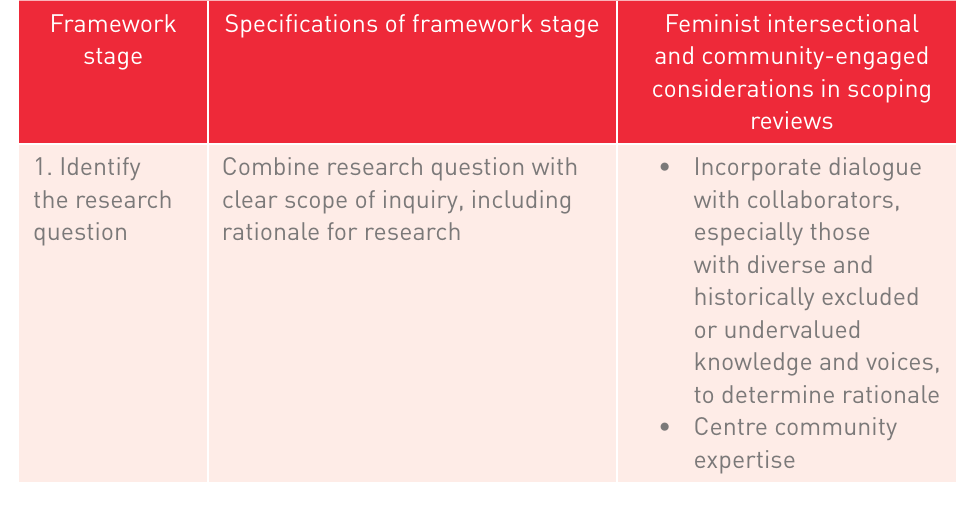
Feminist intersectional community-engaged scoping reviews